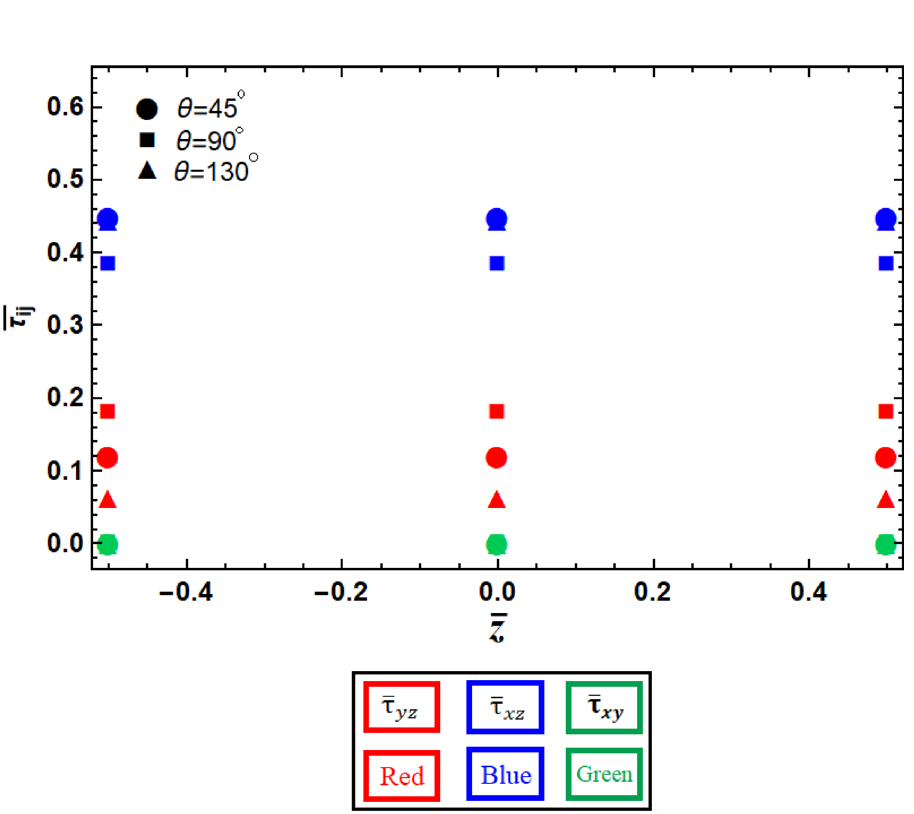
Figure 7. The variation of the components of the shear stresses at different layers of sandwich panels with various re-entrant lattice